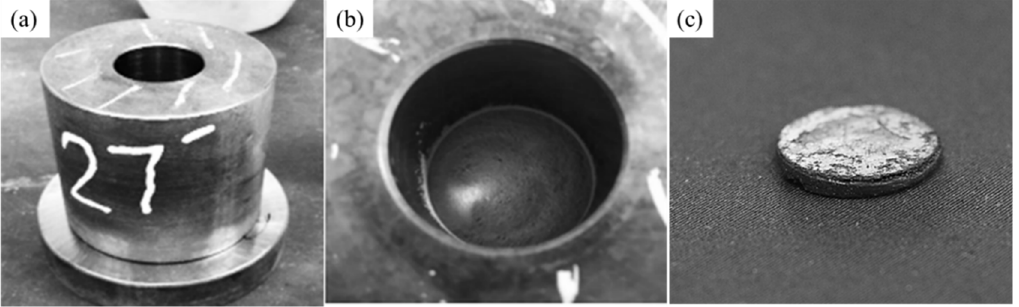
Figure 2. ( a ) Stainless-steel die of 27 mm diameter; ( b ) powder mixture within the die; ( c ) membrane synthesized via compaction process.